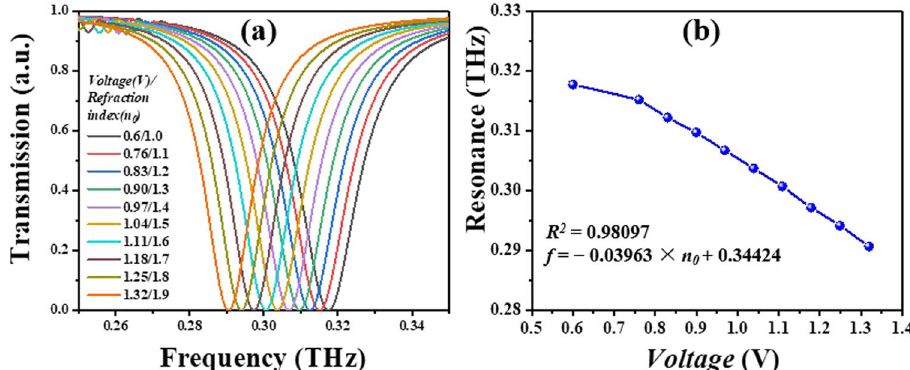
Figure 6. Measured transmission spectra of CLM at different dc bias voltage. ( a ) Transmission spectra of CLM with a = 30 μ m applied different dc bias voltage ( V ) and calculated corresponding refraction index ( n 0 ) at TM mode. ( b ) is the corresponding relationship of resonance and bias ( V ).